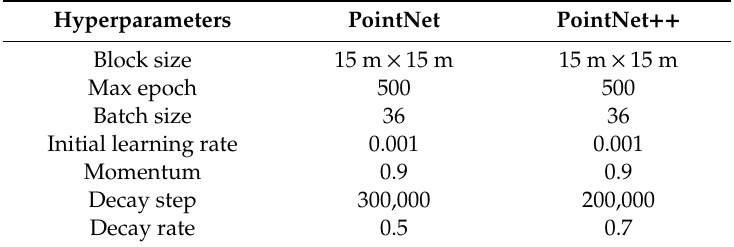
Table 5. Model configuration for PointNet and PointNet++.